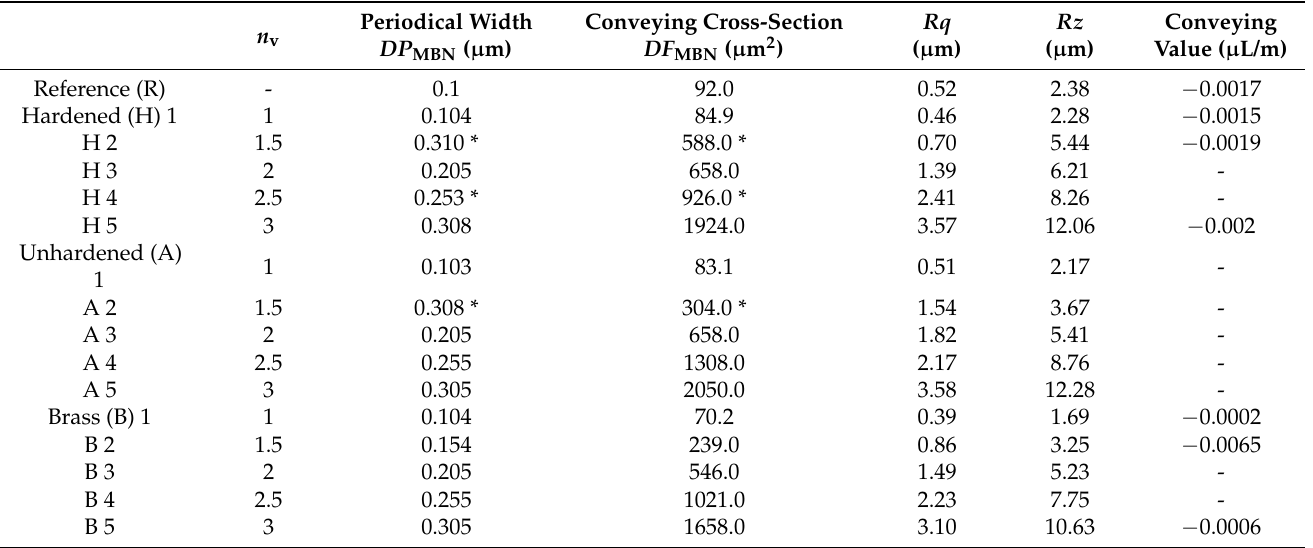
Table 4. Overview of the experiments and the results of surface characterization (* affected by the transition area or surface structure).